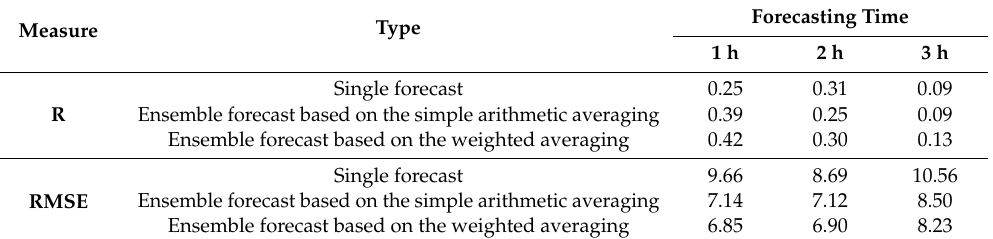
Table 3. Evaluation of the single forecast, the ensemble forecast based on the simple arithmetic averaging, and the ensemble forecast based on the weighted averaging at 09:00 July 8, 2017. Measure Type